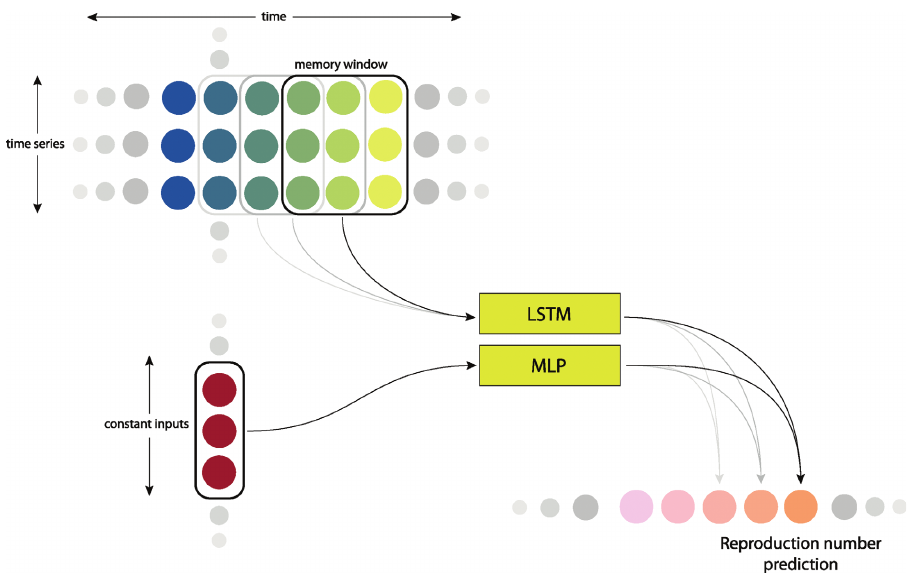
Fig 1. Neural network architecture. Architecture of the hybrid neural network model for predicting R inputs denote the time-invariant input features.